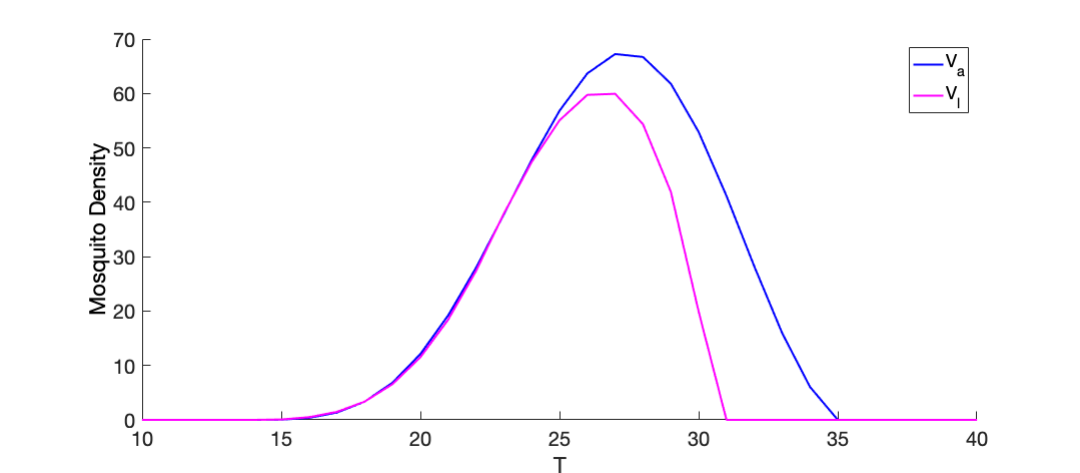
Figure A5. Adult trait-dependent mosquito density V a and life stage trait-dependent mosquito density V l as they vary with the temperature range of 0 ◦ C to 50 ◦ C.